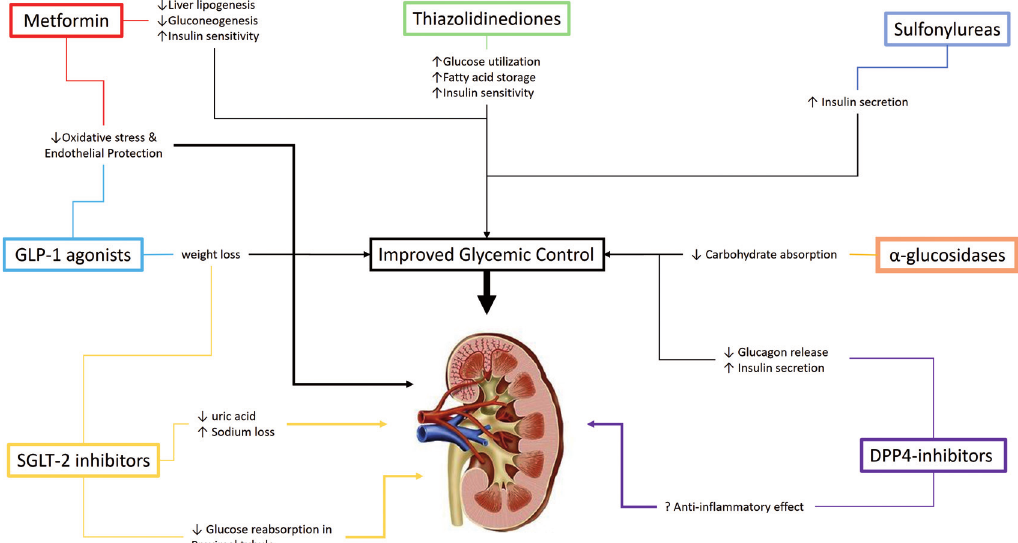
Figure 1. The different antihyperglycemic agents exhibit their renal protective properties through hyperglycemia-dependent and independent mechanisms. This fi gure attempts to map out our understanding of some of these